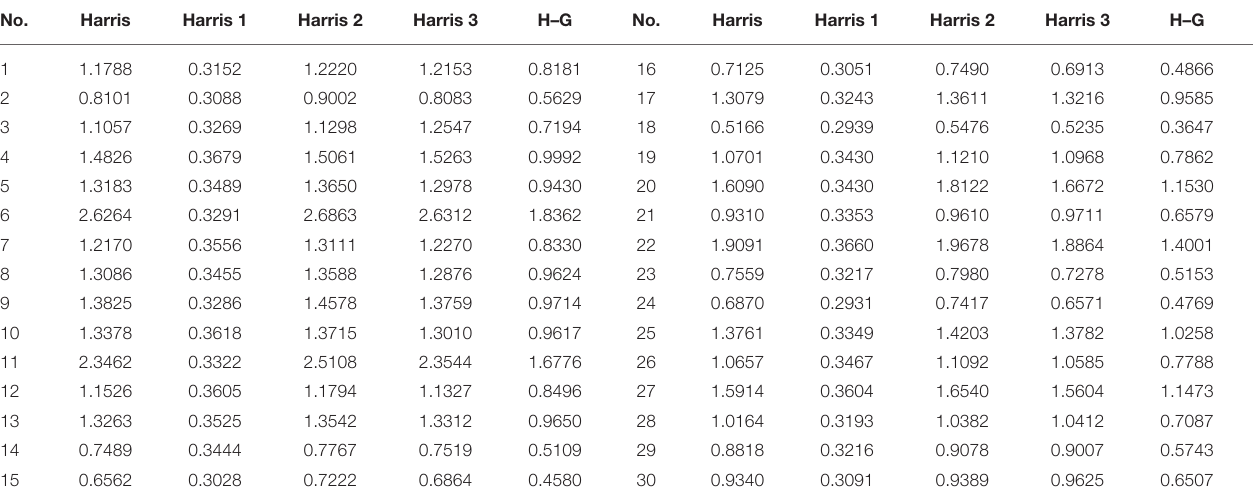
TABLE 1 | Comparison with the average detection time of the five algorithms. No.